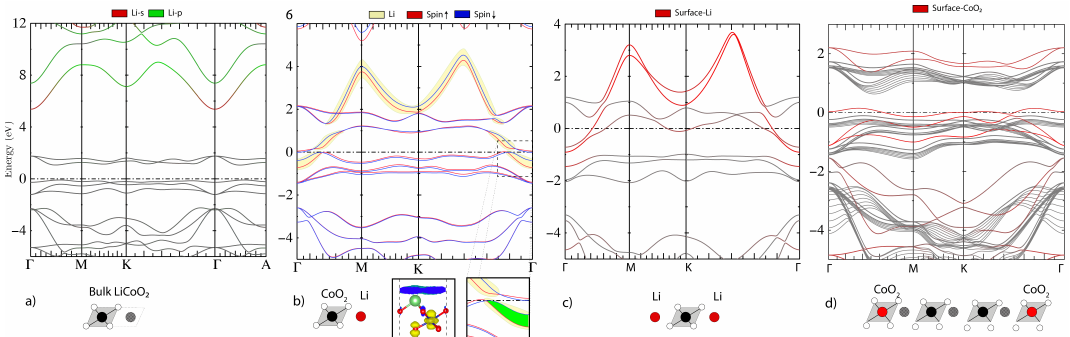
Figure 1: (a) Bulk band structure of LiCoO layer. Insets below, right: zoom in near Γ showing spin polarization in green shad- ing, left: electron density of occupied surface state, (c) symmetric Li terminated Li (CoO ) with x = 1, (d) symmetric CoO x + 1 x 2 neglecting spin-polarization. Structural models are shown below each